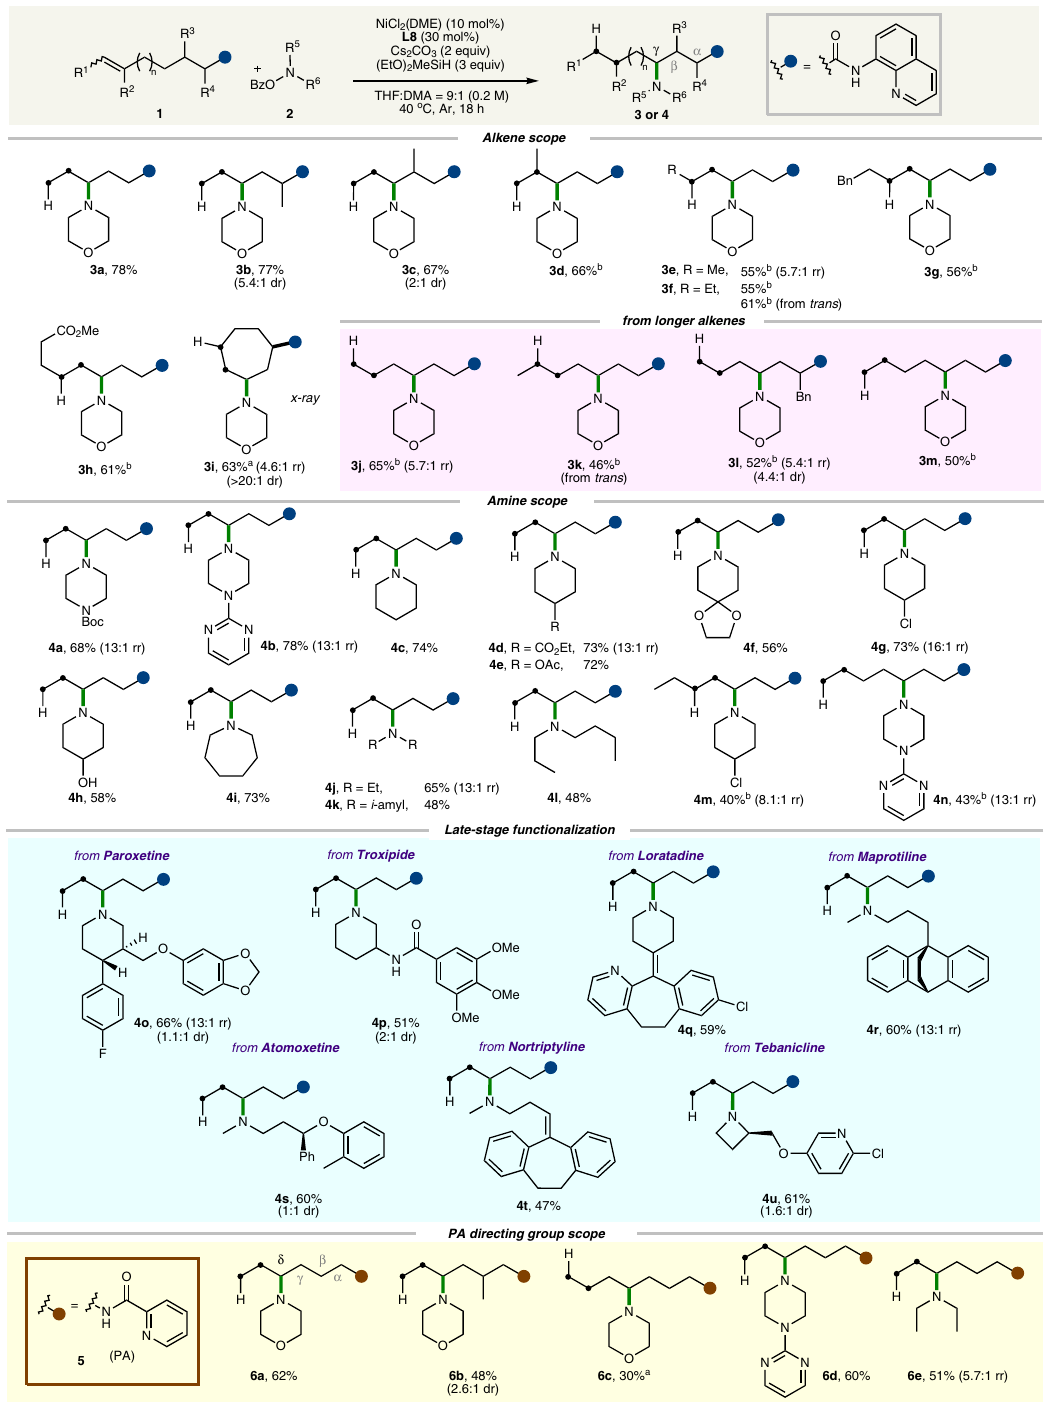
Fig. 3 Substrate scope. Reaction conditions: 1 or 5 (0.1 mmol), 2 (0.2 mmol), NiCl 2 (DME) (10 mol%), L8 (30 mol%), Cs 2 CO 3 (0.2 mmol) and (EtO) 2 MeSiH (0.3 mmol) in THF/DMA = 9:1 (0.5 mL) at 40 °C under Ar for 18 h. cis -Alkenes were used if not denoted otherwise. Yields of isolated γ -product. Isomeric ratios ( γ : β ) were determined by 1 H NMR analysis of the crude mixture (>20:1 rr if not denoted otherwise). a 2 (2.5 equiv) was used at 60 °C. b NiCl 2 (DME), 2 and (EtO) 2 MeSiH were added at 60 °C in two batches of 5 mol%, 1.25 equiv and 1.5 equiv, respectively.